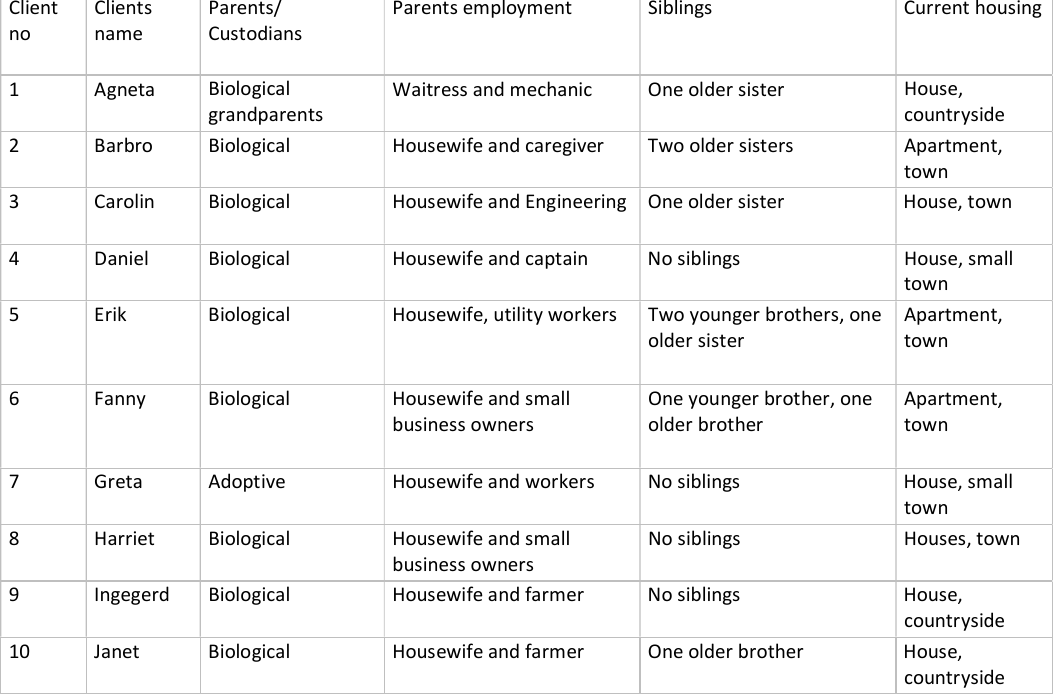
Table 24: Background variables related to childhood environment of 10 clients participating in a TA group